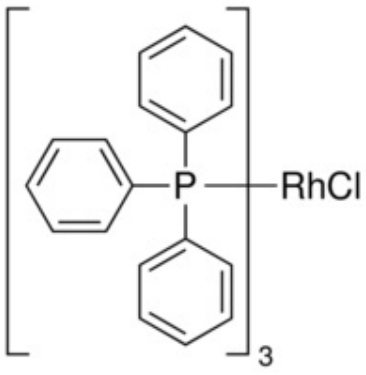
Figure 15. Simplified formula of Wilkinson’s catalyst.